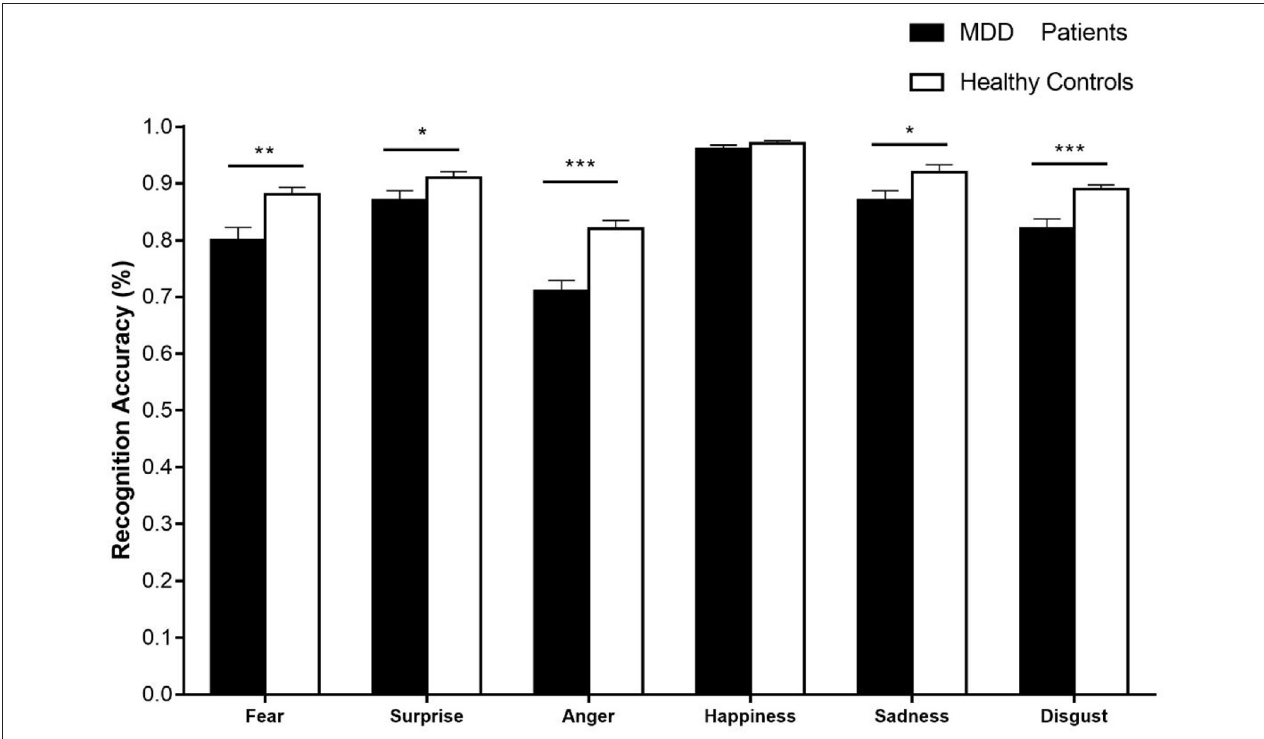
FIGURE 6 | The recognition accuracies of six basic emotional expressions in patients with MDD and healthy controls. Error bars represent SEMs. * p < 0.05; ** p < 0.01; *** p <